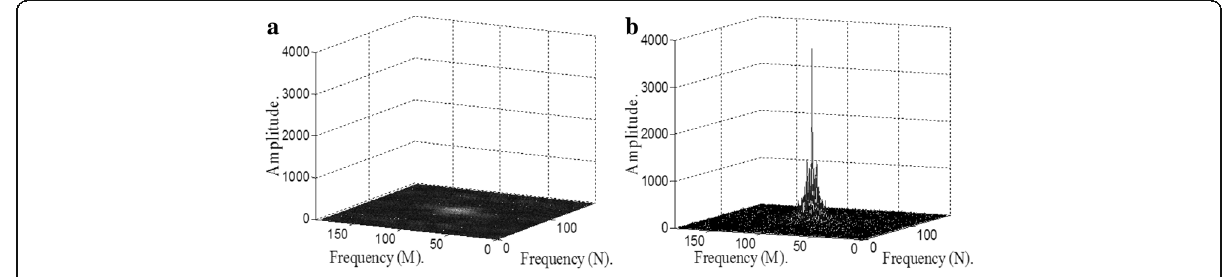
Fig. 7 Amplitude and frequency spectrums of X-ray radiography images of GAC-virgin ( a ) and GAC-Top “ exhausted ” ( b